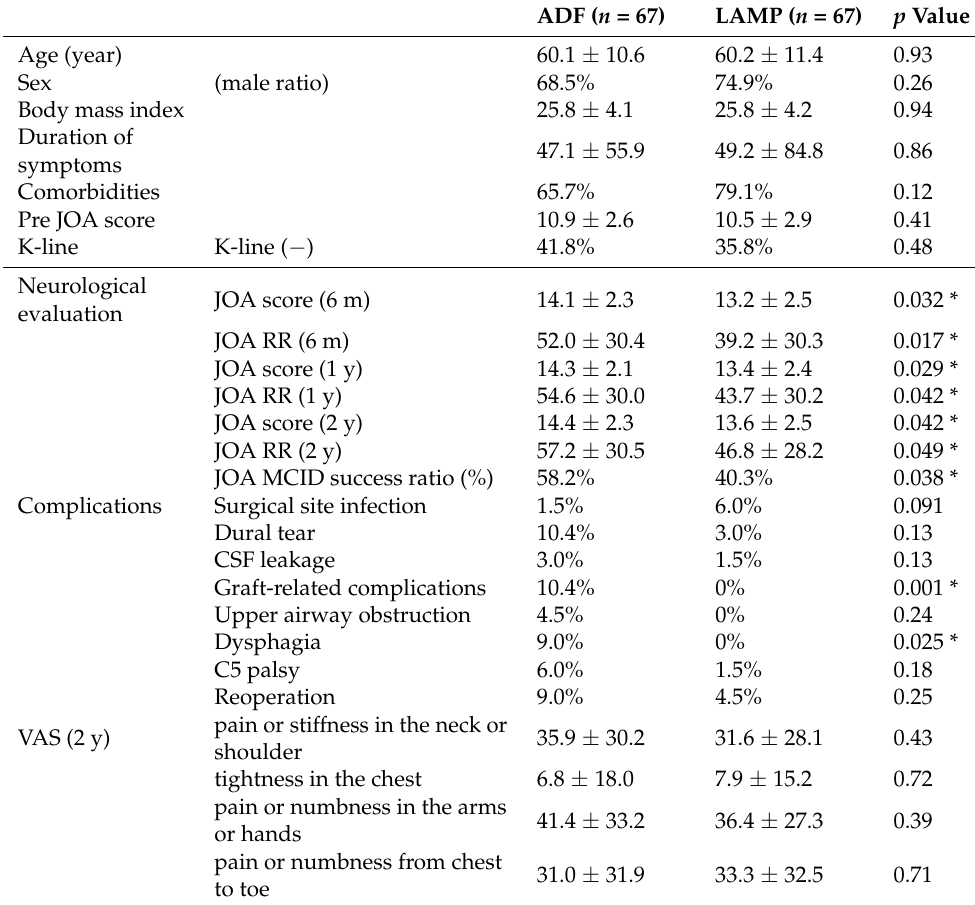
Table 5. Comparison of matched patients of ADF and LAMP